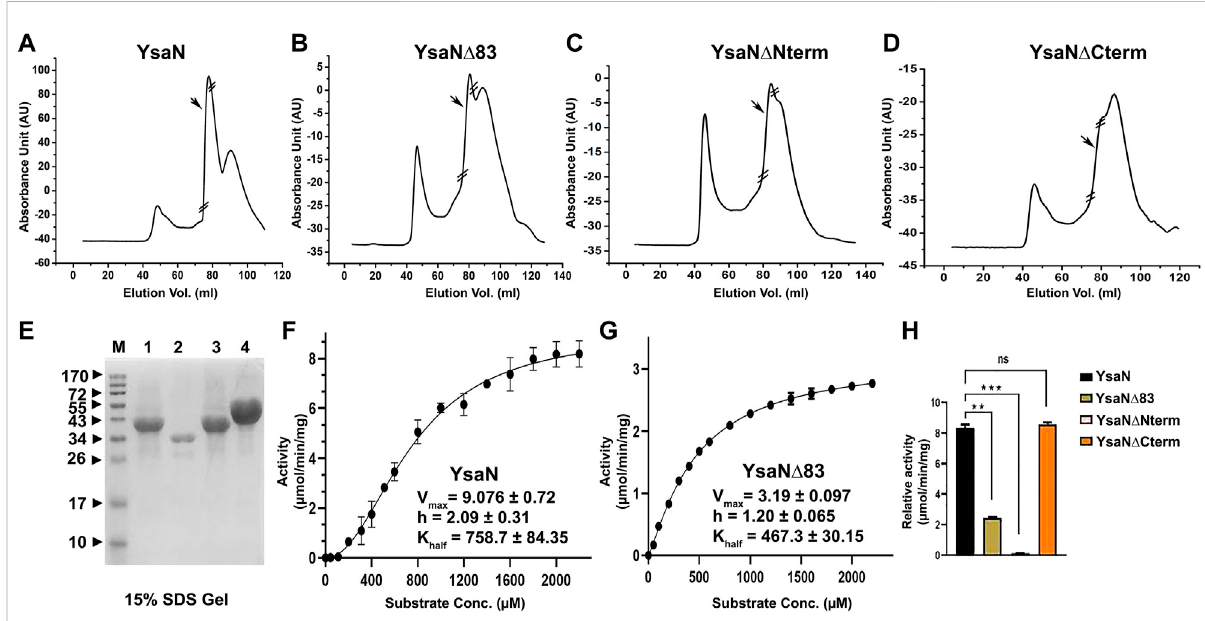
FIGURE 2 Puri fi cation and characterization of YsaN- (A – D) — Typical size exclusion chromatography pro fi le of YsaN, YsaN Δ 83, YsaN Δ Nterm, and YsaN Δ Cterm respectively using Superdex 16,600 columns. Respective collected peaks are delimited by crossed sections of the chromatograms. (E) SDS gel pro fi le of collected peaks from gel fi ltration (Lane M-Marker, Lane1- Peak from (D) , Lane2- Peak from (C) , Lane3- Peak from (B) , and Lane4- Peakfrom (A) . (F) -Standard enzymeassaycurveofpuri fi edYsaNmeasuring µmols ofphosphatereleasedperminutespermilligrams ofprotein using the malachite green method for inorganic phosphate estimation, inset showing V max , K half, and Hill coef fi cient values. (G) - Standard enzyme curvefor YsaN Δ 83intermsofµmolsofphosphatereleasedperminutepermilligrams ofprotein,insetshowingV max ,K half, andHillcoef fi cient values. (H) -Comparisonof relativeATPaseactivityof puri fi edYsaN toYsaN Δ 83,YsaN to YsaN Δ Nterm,YsaN to YsaN Δ Cterm(also please seeSupplementary FigureS5A,BforfurtherdetailsofenzymekineticsofYsaN Δ 83andYsaNK166 → Aandrelativeassay).Errorbarsindicatestandarddeviationinallcases. Statistically signi fi cant differences by unpaired Student ’ s t -test are indicated with asterisks ( ” +++ ” means p < 0.001; “ ++ “ p > 0.01; “ ns ” means non- signi fi